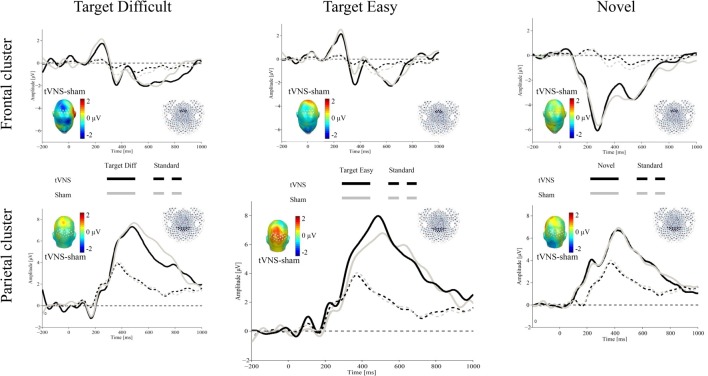
Grand average event-related potentials (ERPs) evoked by target difficult (left), target easy (middle) and novel (right) stimulus (thick lines) and standard stimulus (dotted lines) for the transcutaneous vagus nerve stimulation (tVNS; black) and sham (gray) conditions (N = 17). The waveforms represent the ERPs averaged across electrodes within a frontal cluster (upper part) and a central-parietal sensor cluster (lower part) to extract the P3a and P3b, respectively. The scalp topographies of the ERP difference between both conditions are plotted in the inset.